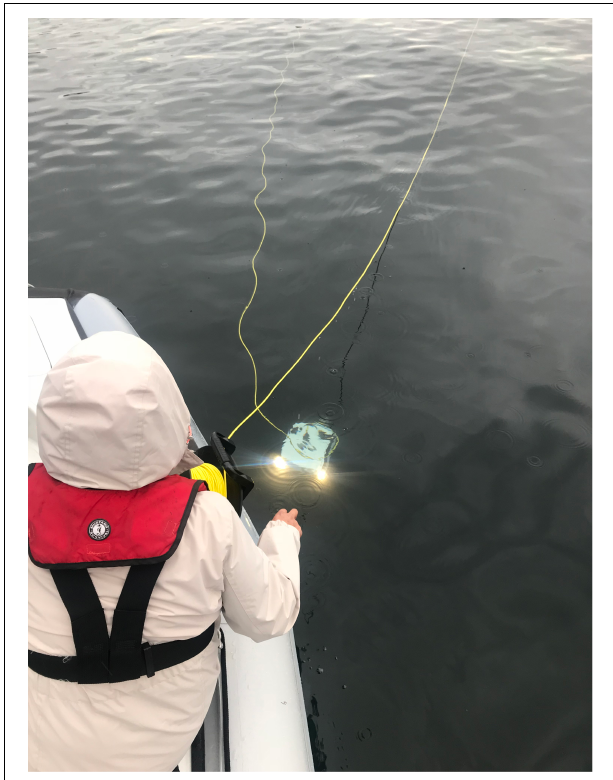
FIGURE 2 | Image of the Trident as it returns to the survey team after a